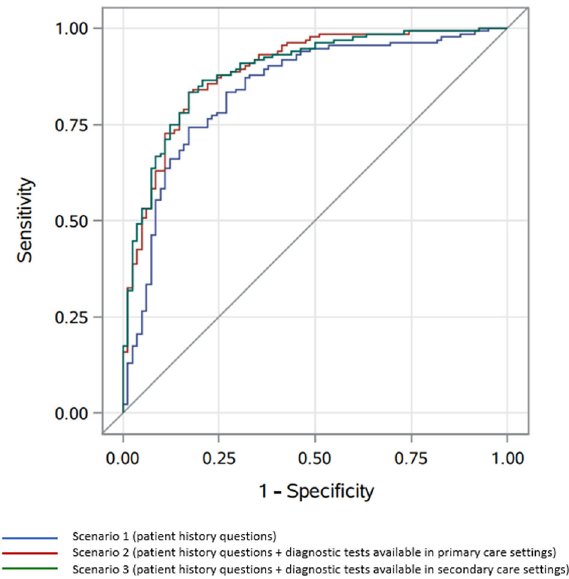
Fig. 3 Receiver operating characteristic (ROC) curves for the three scenarios* to differentiate between asthma and COPD diagnoses ( n = 222). *Area under the curve (AUC) values and p -values of comparison between Scenario 1 and 2 and Scenario 2 and 3: see Table